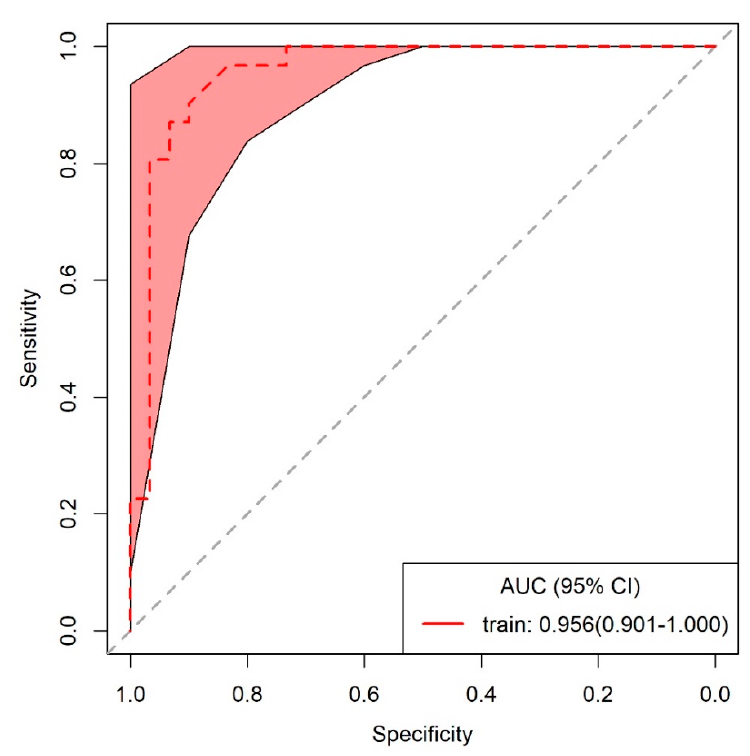
Figure 2. Receiver operating characteristic (ROC) curve applied to distinguish tuberculoma from lung adenocarcinoma. AUC: area under the ROC curve; 95% CI: confidence interval. Table 2. CT morphological features in patients with tuberculoma vs. those with